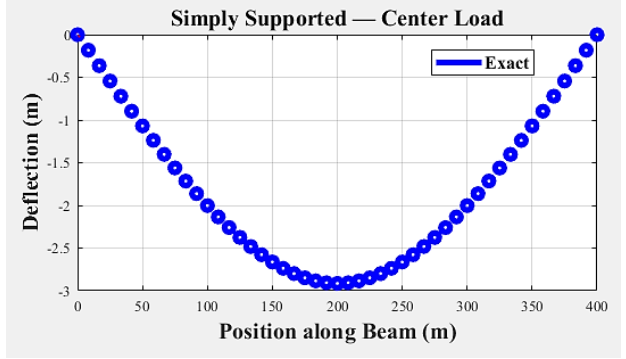
Fig. 10. Direction of total deformation (-3×10 -5 mm) of cemented carbide, simply supported beam with centre load of 1000 N by MATLAB